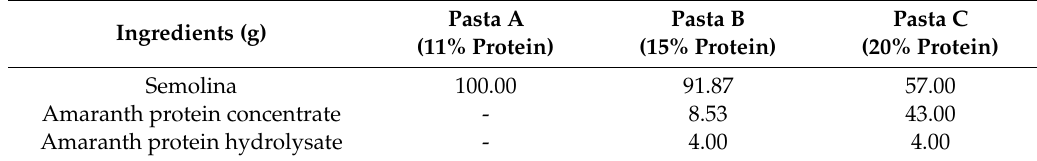
Table 1. Formulations for pasta making with changes in the content of protein *. Pasta Ingredients (g)